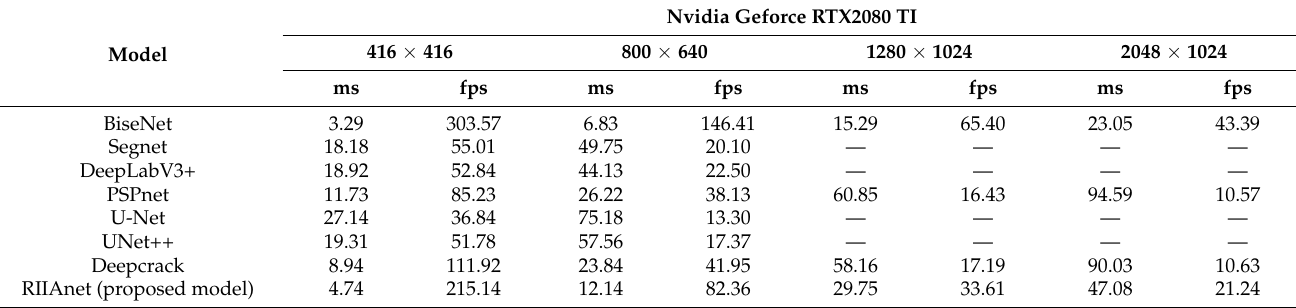
Table 4. Inference speeds for alternative